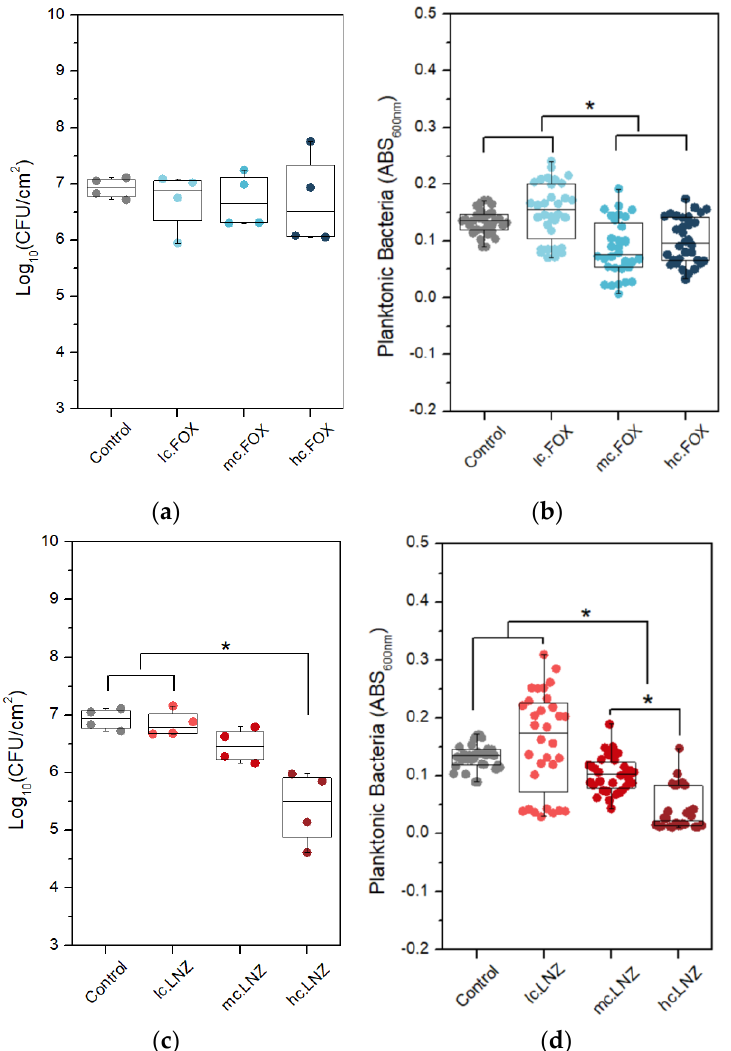
Figure 7. S. aureus colony-forming units per square centimeter ( a , c ) and planktonic bacteria ( b , d ) following strain incubation of titanium discs coated with Control, FOX-loaded coatings ( a , b ), or LNZ-loaded coatings ( c , d ). Data are represented as median and interquartile range. * p -value < 0.05 for Wilcoxon test.